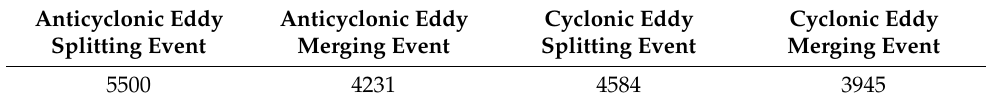
Table 2. The numbers of typical anticyclonic/cyclonic eddy splitting/merging events used for the eddy-induced SSTA composite analysis during January 1996–December 2019.